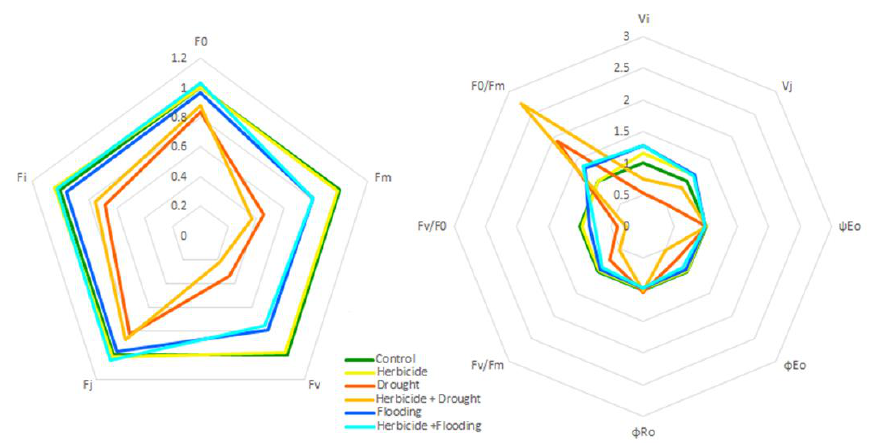
Figure 6. Spider plot of the chlorophyll fluorescence parameters in wheat plants after 7 days of drought or flooding.